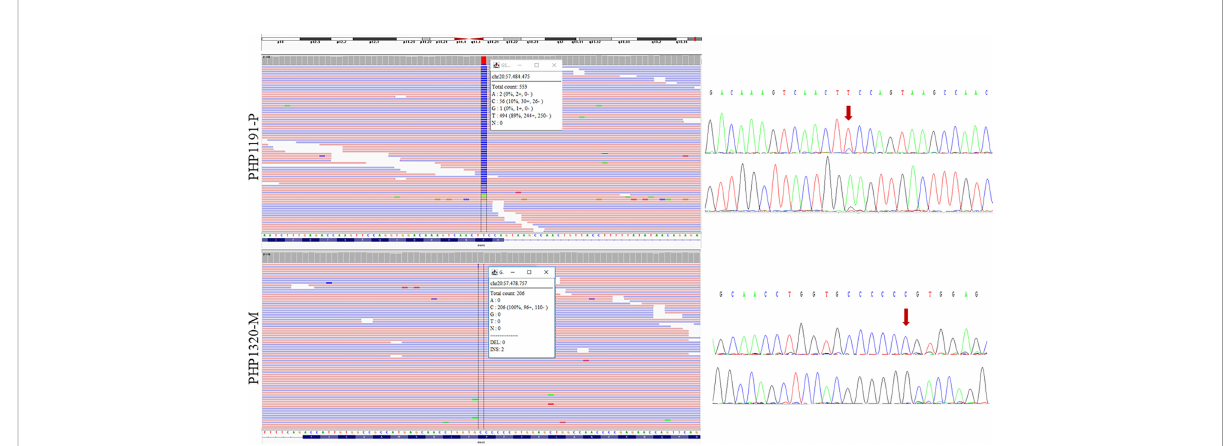
FIGURE 2 Sequencing results of the two parents carrying the mosaic variants. NGS results are shown on the left and Sanger sequencing results on the right (for each sample, upper panel for forward sequencing, bottom for reverse; the red arrow indicates the position of the change). Integrative Genomics Viewer (IGV) (27) was used for visualizing the variants identi fi ed by NGS. Reads are sort by base, showing the variant in the upper part of the reads ’ track. Information in the box indicates the number of total reads at the position of interest, the count of each base at that position and the percentage of each allelic variant. PHP1191-P is an asymptomatic father whose NGS sequencing revealed the presence of the mutated C variant in around 10% of the reads; reanalysis of Sanger sequencing allowed the observation of a small peak. The duplication of a C in PHP1320-M (mother) was observed in 2 of 206 NGS reads; however it could not be observed at Sanger sequencing. The transcript used as reference was